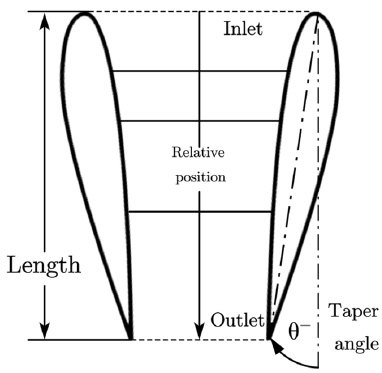
Figure 14. Duct’s structure scheme.